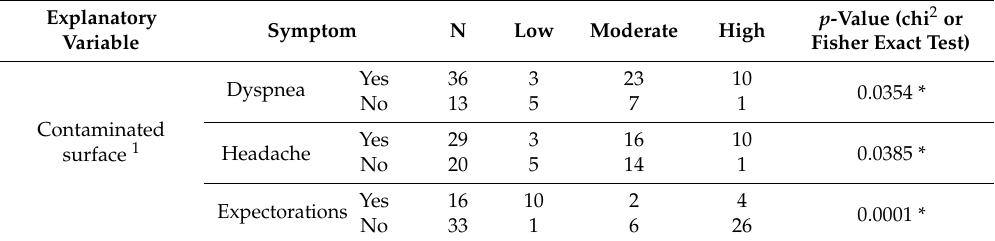
Table 7. Contaminated surface as explanatory variable of the symptoms mentioned by inhabitants. Explanatory Variable